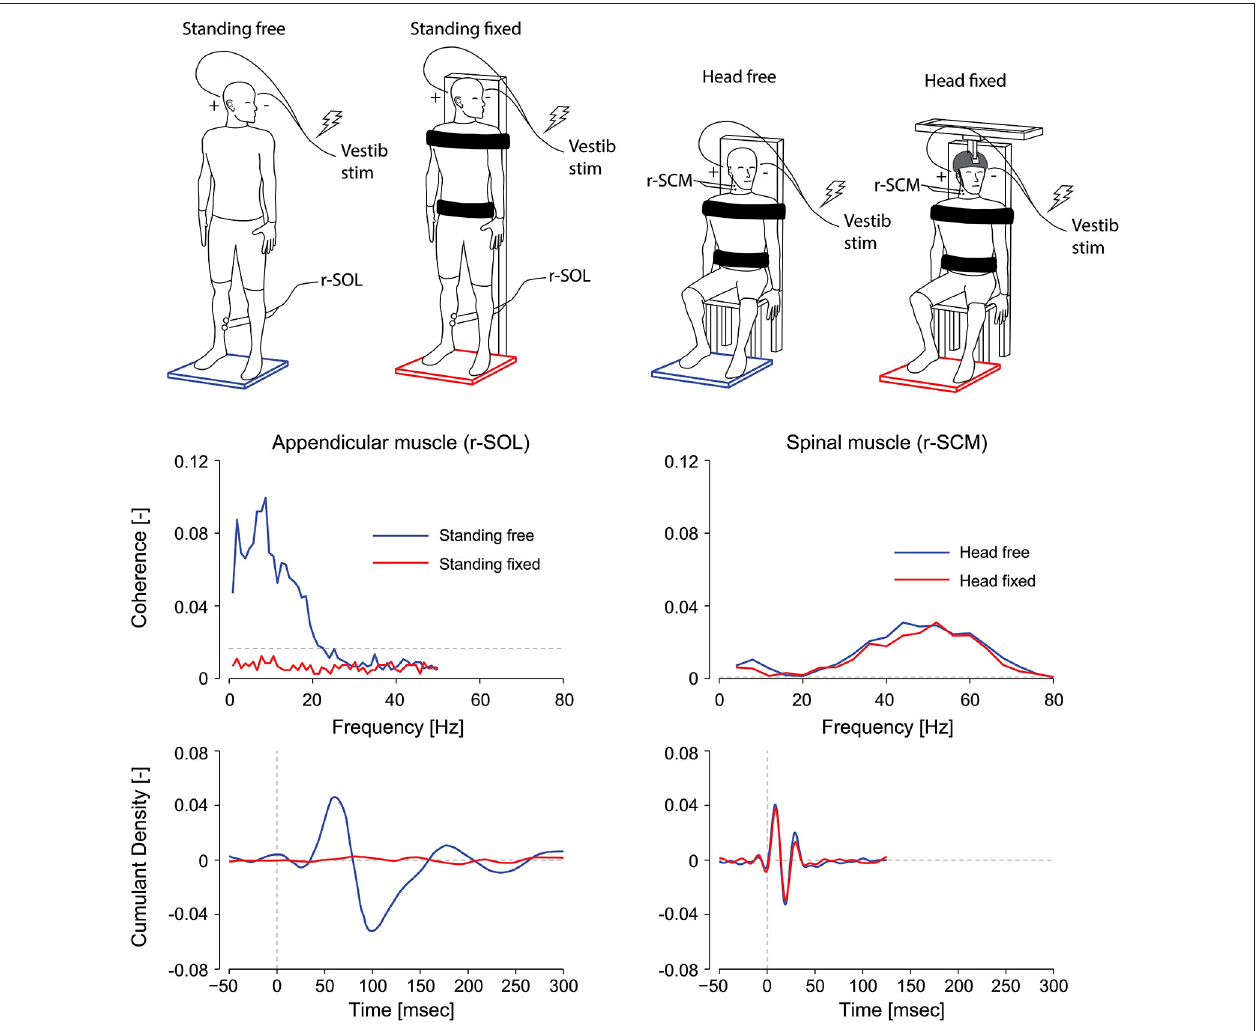
to the torso. Thus, vestibular-evoked responses are present in axial muscles, unlike appendicular muscles, regardless of the postural task. r-SOL, right soleus; r-SCM, right sternocleidomastoid. The horizontal, segmented lines in the coherence plots represent the level above which the coherence is significant. (Data are adapted from Luu et al., 2012; Forbes et al.,